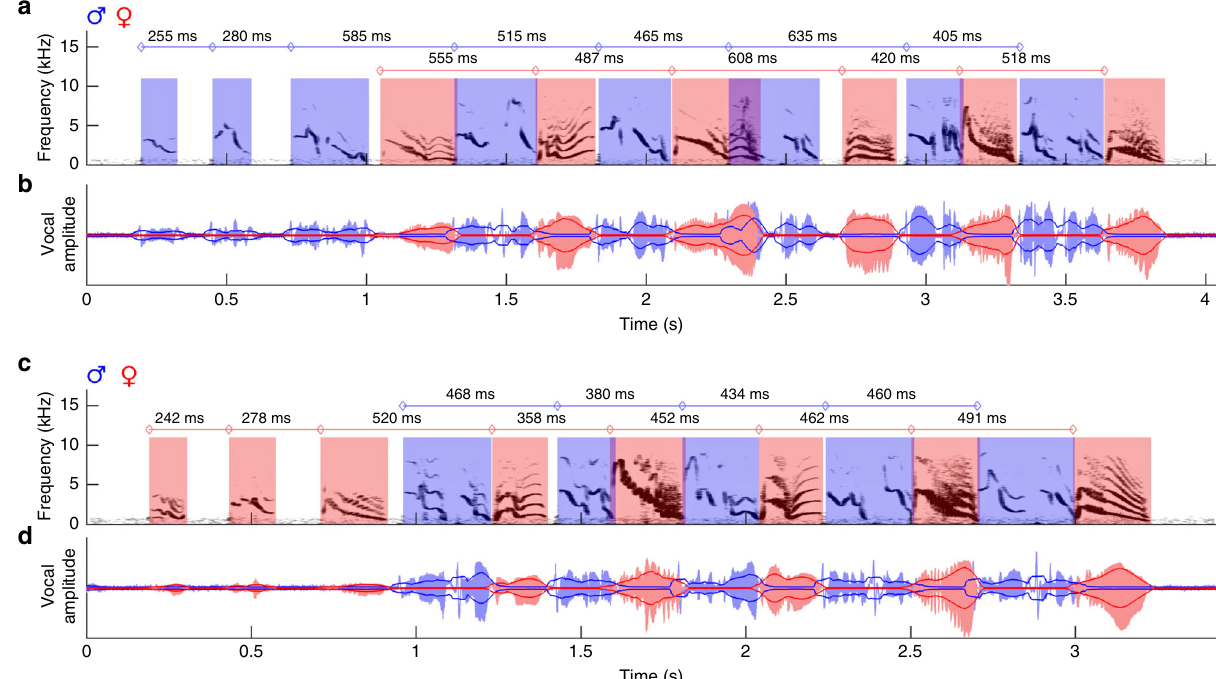
Fig. 2 Male and female syllables alternate precisely during duetting. The spectrogram ( a , c ) and amplitude waveform ( b , d ) of the combined male and female vocal traces are shown for exemplary duet bouts initiated by the male ( a , b ) or by the female ( c , d ) of Pair #4. Male signals are coded in blue and female signals are coded in red. Solid dark blue and dark red lines outline the root-mean-square envelope (see “ Methods ” ) of the amplitude waveforms. Onset – onset intervals of male and of female duet syllables are given by values above the